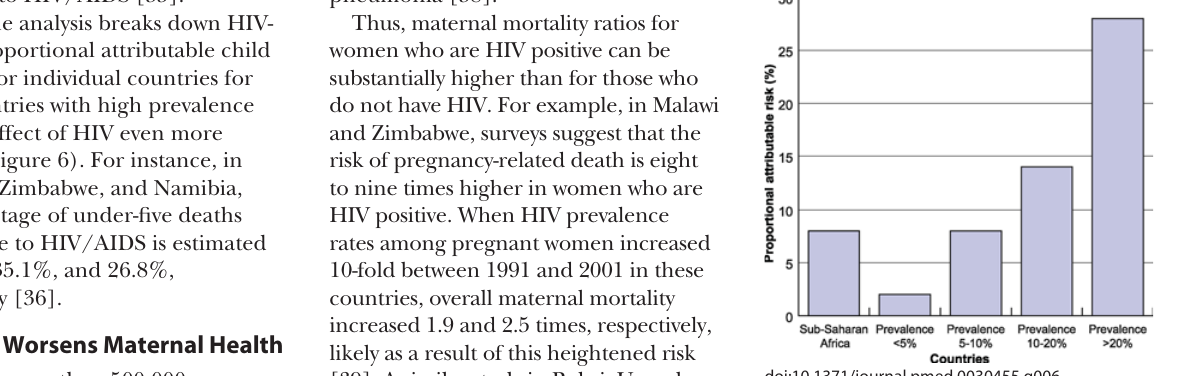
Figure 6. HIV-Related Population Proportional Attributable Risk of Dying before Age Five, Sub-Saharan Africa, 1999 Figure derived from